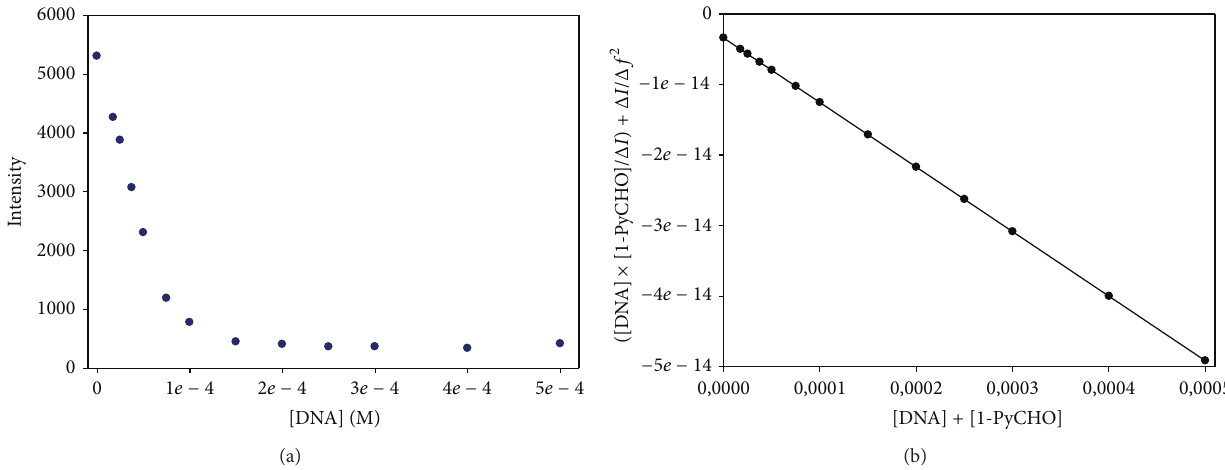
= 458 nm) of 1-PyCHO with DNA in the presence of Au@tiopronin nanoparticles. ([1-PyCHO] = Figure 6: (a) Fluorescence titration ( 𝜆 em 5 × 10 −7 M; [AuNPs] = 6 × 10 −7 M; [DNA] = 0– 5 × 10 −4 M, given in base pairs). (b) Fit of the data to Hildebrand-Benesi model. Δ𝐺 = −𝑅𝑇 × ln( 𝐾 1 -PYCHO / DNA ) were obtained. However, the values of Δ𝐺 represent the affinity of 1-PyCHO for the binding to DNA relative to the solutions where the free pyrene-1- carboxaldehyde is present . Obviously, Δ𝐺 cannot be compared